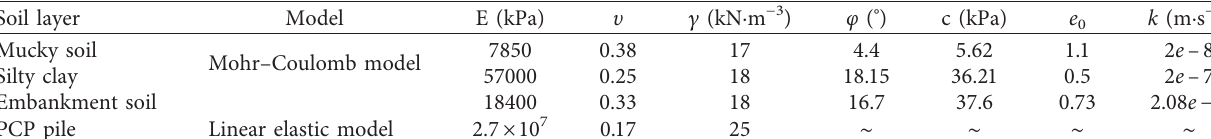
Table 2: Model material